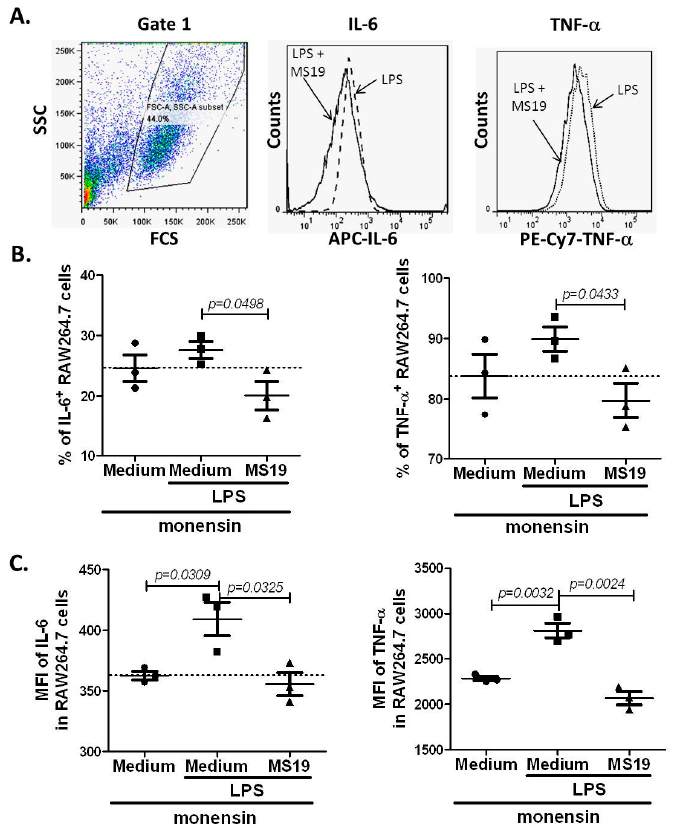
Figure 6. MS19 down-regulated the expression levels of IL-6 and TNF- α protein in LPS-treated RAW264.7 cells. RAW264.7 cells were cultured in medium containing LPS (1 µg/mL) + monensin (1 µL/mL) or LPS (1 µg/mL) + monensin (1 µL/mL) + MS19 (8 µg/mL) for 4 h, and then stained with APC rat anti-mouse IL-6 and PE-Cy7 rat anti-mouse TNF- α mAb. Afterward, the cells were analyzed on a flow cytometry. The data were representative of three independent experiments. ( A ) Gates and data from flow cytometry analysis. Left: Total of the RAW264.7 cells. Middle: Ratios of IL-6 + RAW264.7 cells between the group of saline and MS19. Right: Ratios of TNF- α + RAW264.7 cells between the group of saline and MS19; ( B ) Percentage of IL-6 + and TNF- α + in the RAW264.7 cells; ( C ) MFI of IL-6 and TNF- α in the RAW264.7 cells.